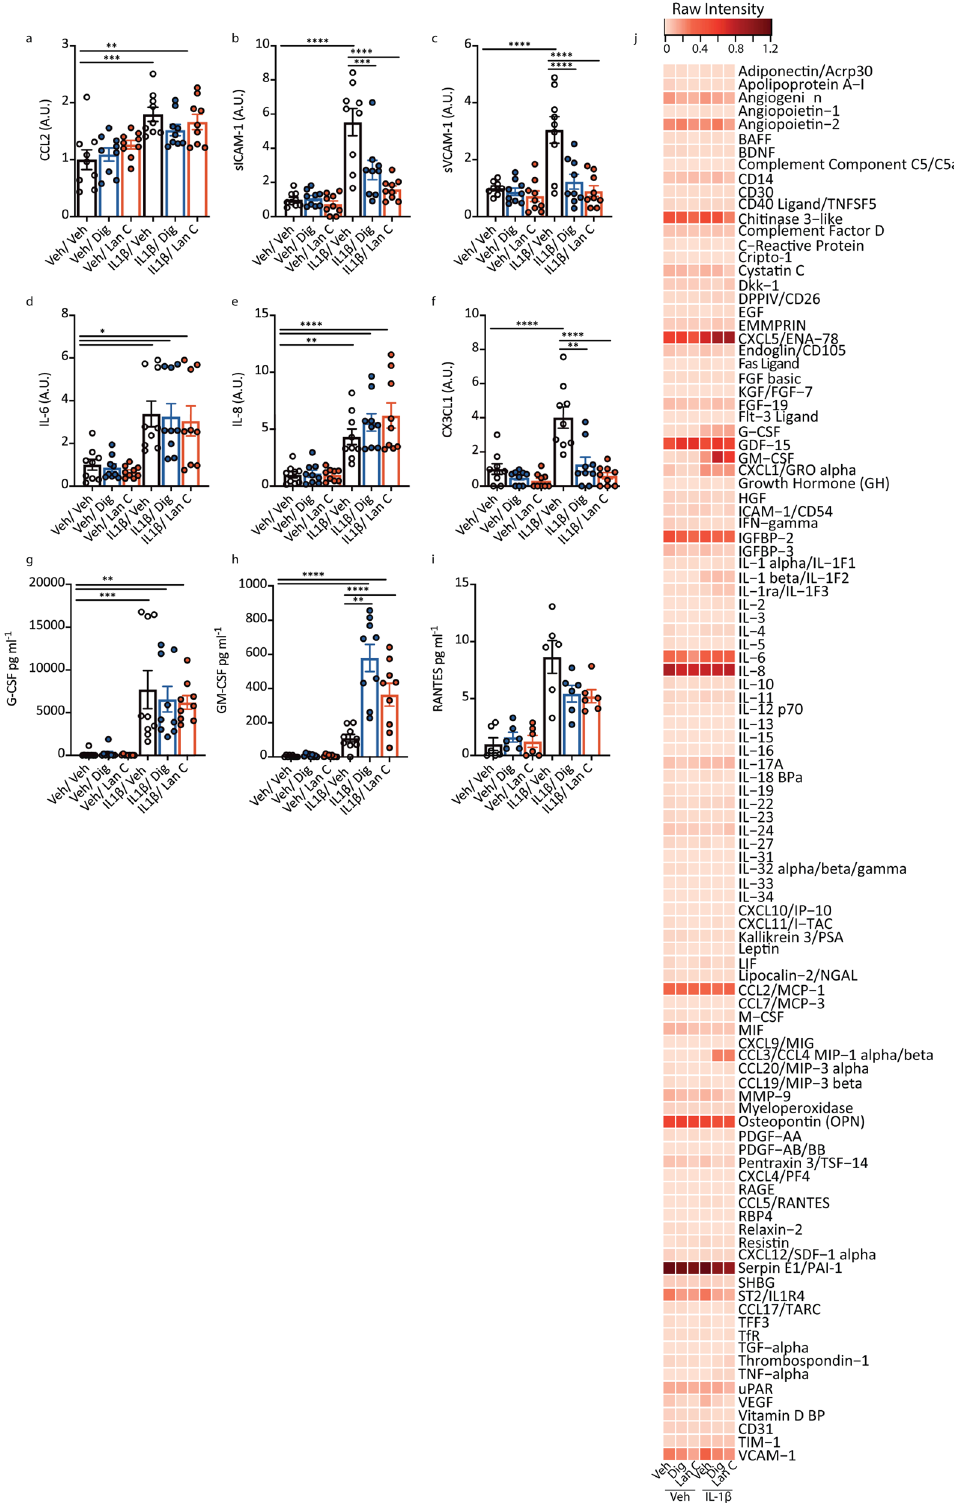
Fig. 8 Cardiac glycosides modulate in fl ammatory responses in choroid plexus explant cultures. a – i Choroid plexus explants were treated with vehicle (white bars), digoxin (blue bars) or lanatoside C (red bars) (both 10 µ M) for 24 h followed by IL1 β (10 ng mL − 1 ) for 24 h. Secretions were measured using CBA ( n = 3 ( n = 2 for RANTES) cases used: HC166, HC171, PD85, three explants per case) **** p < 0.0001, *** p < 0.001, ** p < 0.01, * p < 0.05. Values normalised to vehicle for each case, except for G-CSF, GM-CSF and RANTES as vehicle condition was under the level of detection, (raw data provided in Supplementary, Fig. S9). j Proteome pro fi ler analysis of pooled choroid plexus explant secretions ( n = 2, cases used FTD6, HC153 pooled explants per case). Data are presented from the average of each case normalised to reference